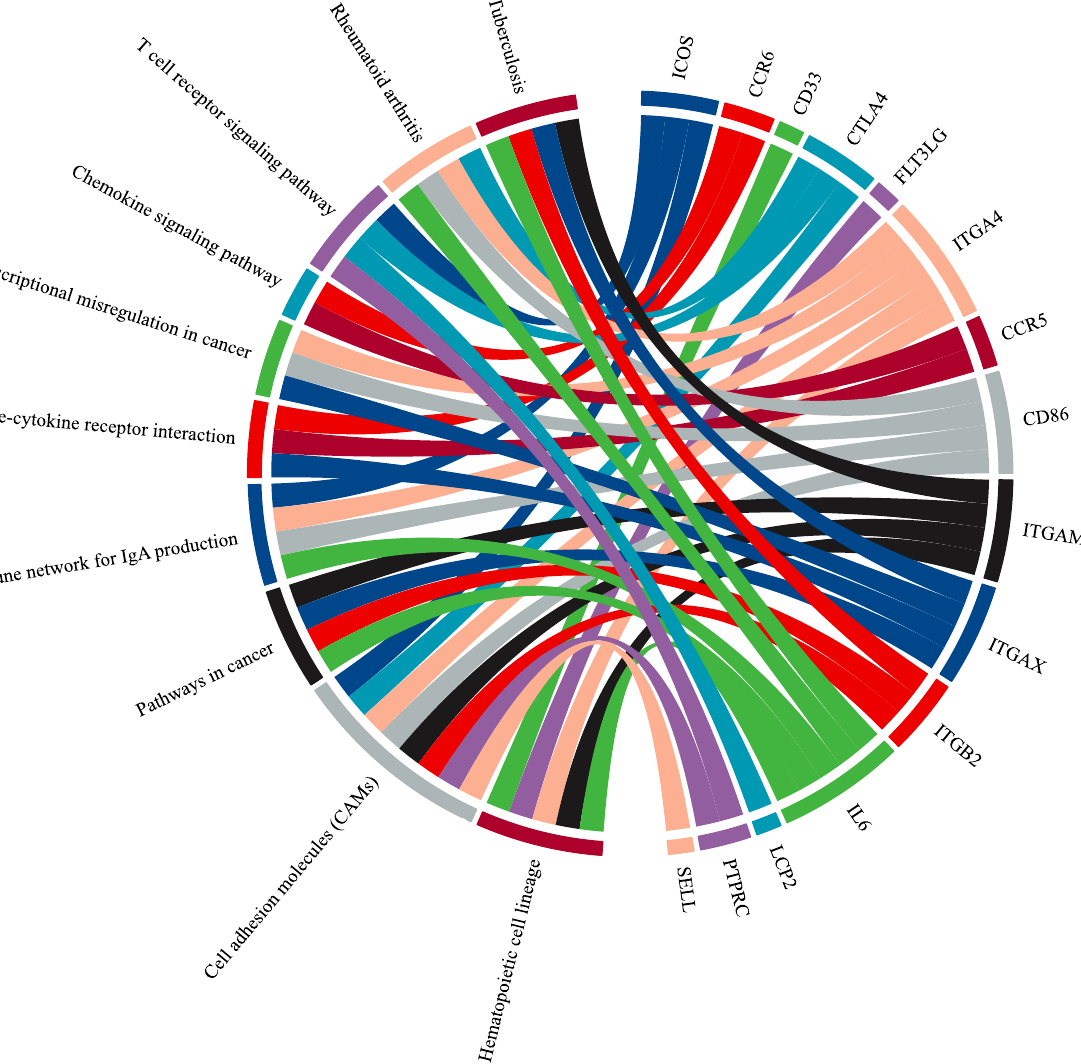
left) and the top 10 leading hubs and key regulators (on the right). Each gene has a different color band, and the undirected colored edge inside the circle represents the relationship of a particular gene with their respective connected